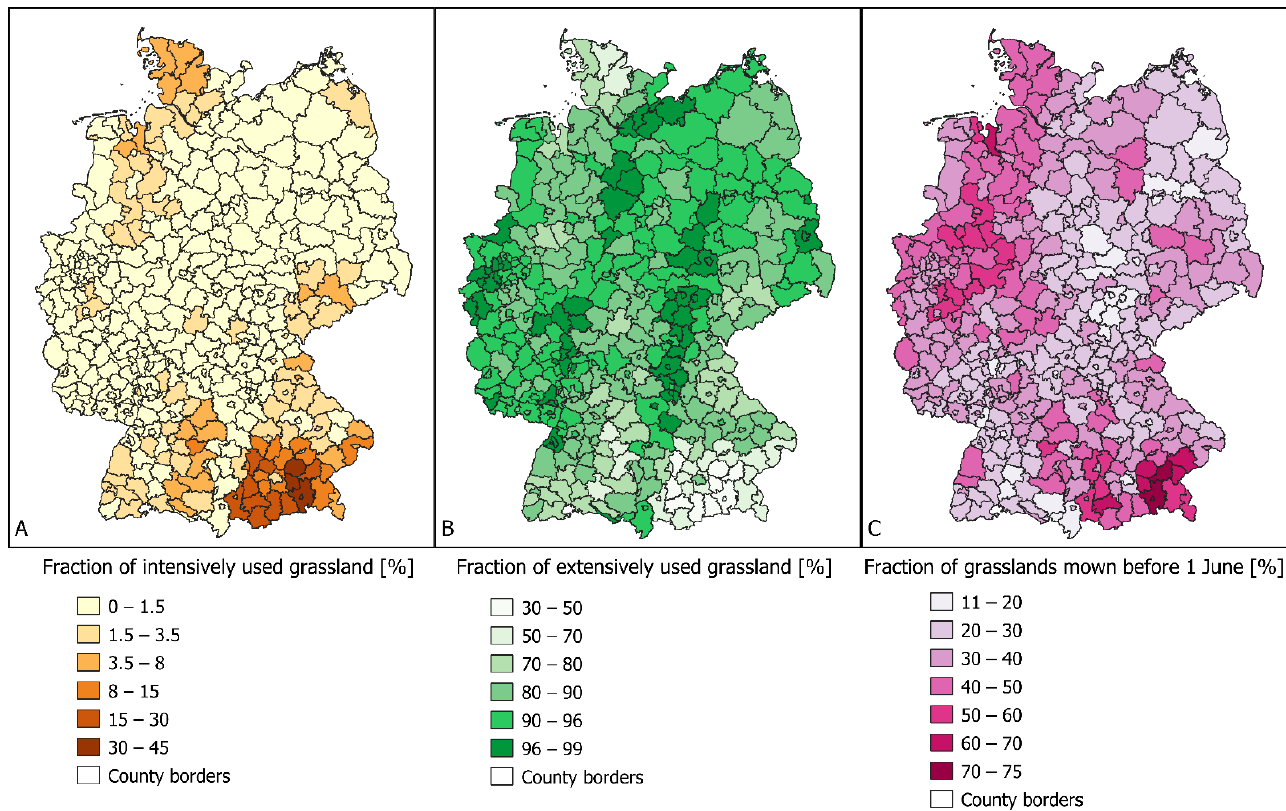
Figure 13. Fractions of grasslands within counties, which are used intensively (mown four to six times; ( A )), extensively (mown zero to two times; ( B )), and mown before the ecologically critical 1st of June ( C ).